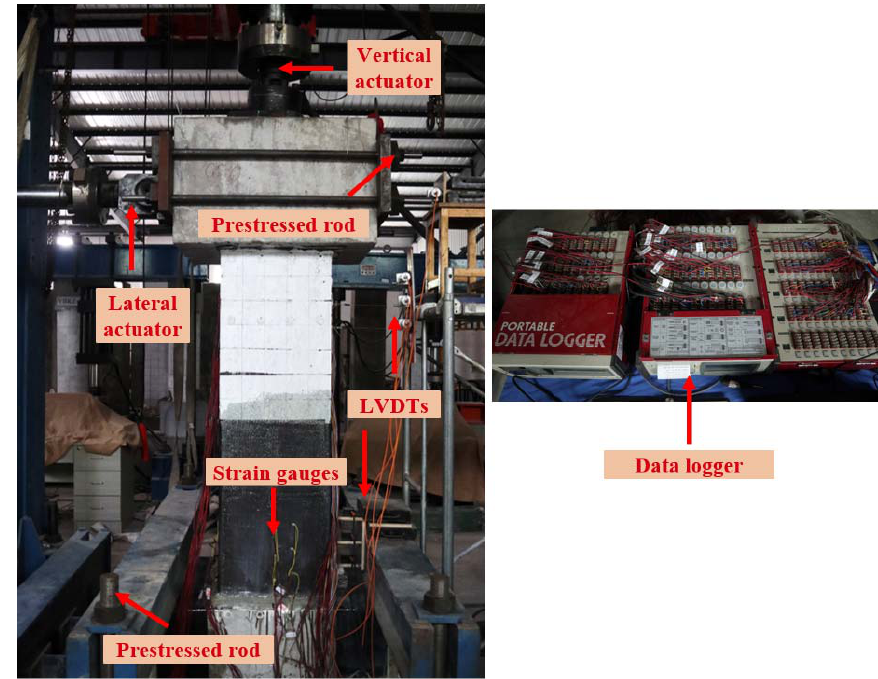
Figure 6. Test step and instrumentation.